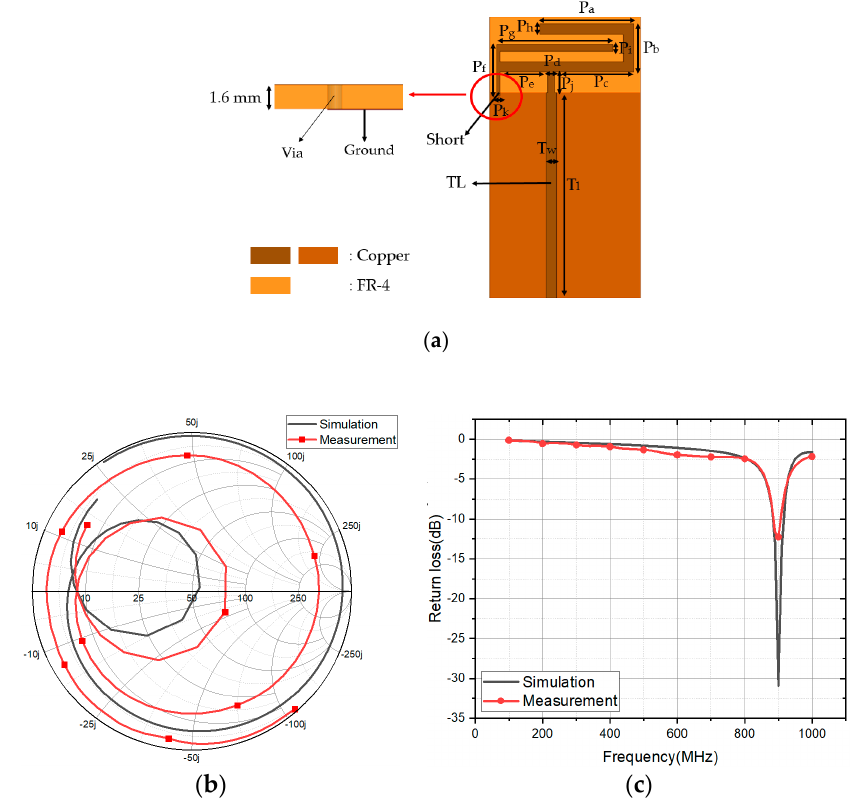
Figure 1. ( a ) Geometrical parameters of planar inverted-F antenna (PIFA); ( b ) Simulated and measured input impedances on Smith Chart; and, ( c ) Simulated and measured return